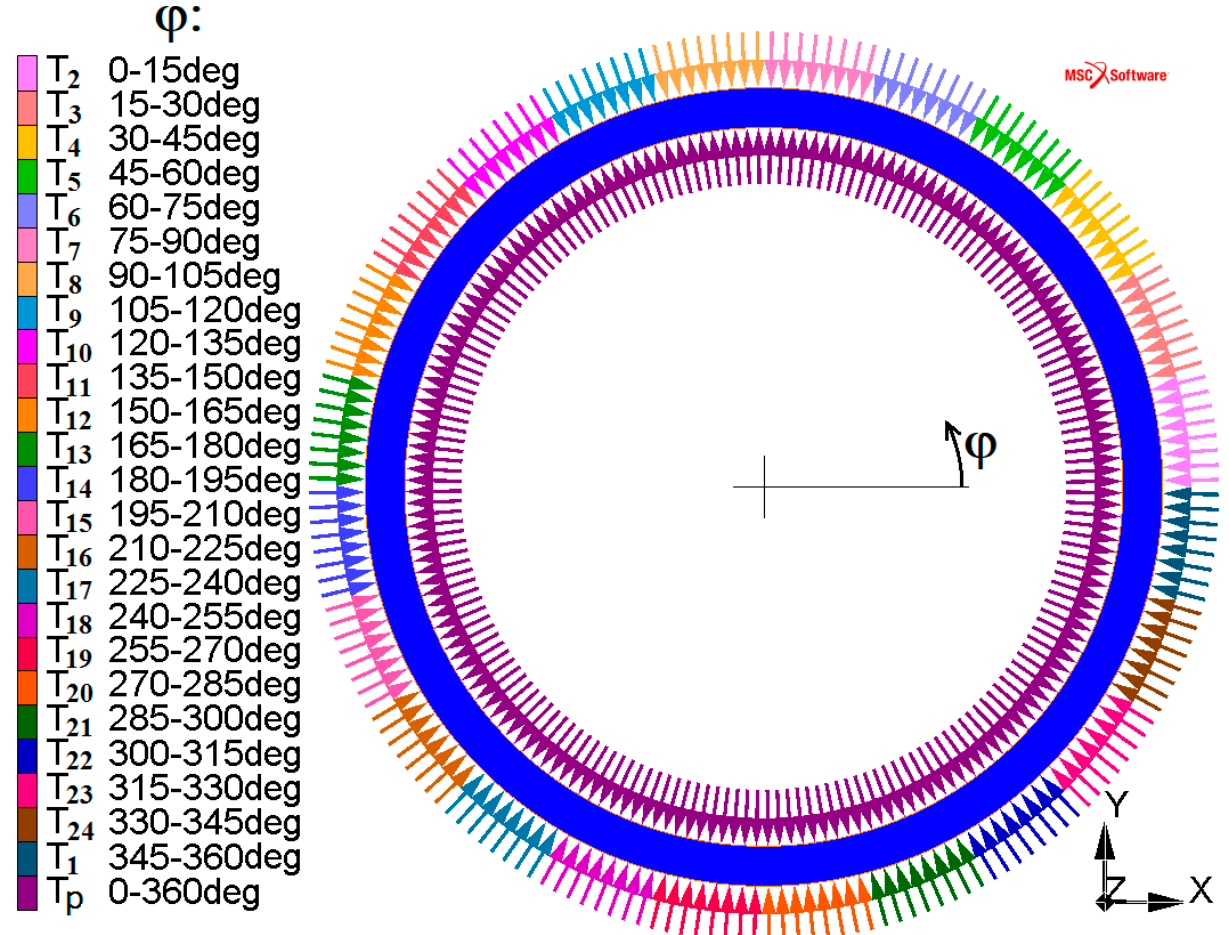
Figure 4. ‘Earthcylinder’ with temperature loads (not to scale).